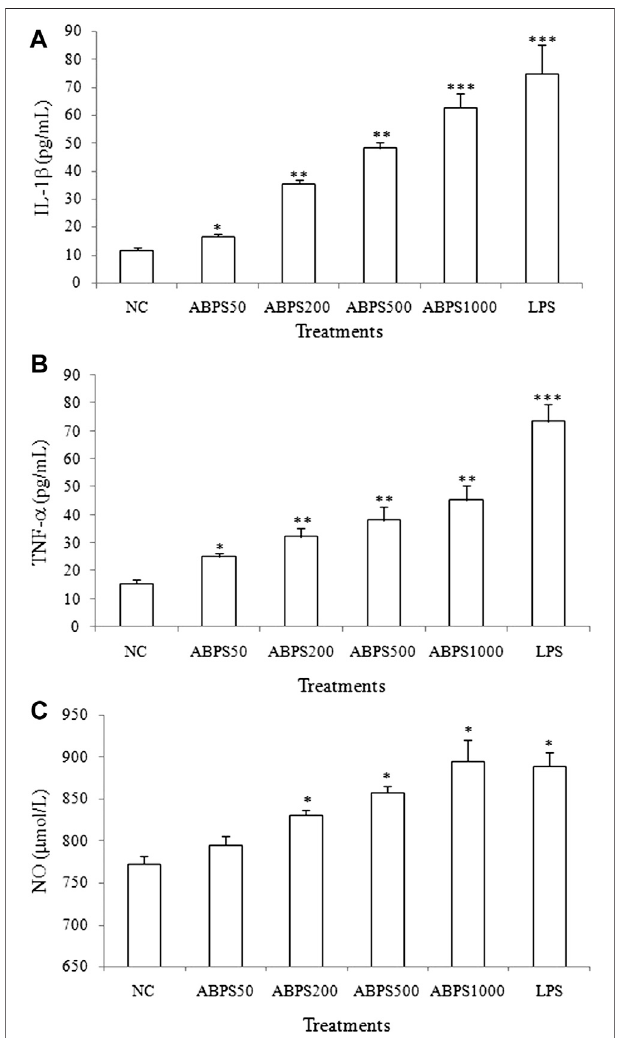
FIGURE 1 | Effects of ABPS on the secretion of cytokines and NO in J774 A.1 cells. The cells were treated with ABPS (0, 50, 200, 500, and 1,000 μ g/ml, respectively) or LPS (5 μ g/ml) for 24 h. Cell culture medium was collected, and the secretion levels of cytokines (A) IL-1 β , (B) TNF- α , and (C) NO were detected. NC: normal control; ABPS50: 50 μ g/ml ABPS treated; ABPS200: 200 μ g/ml ABPS treated; ABPS500: 500 μ g/ml ABPS treated; ABPS1000: 1,000 μ g/ml ABPS treated; and LPS: 5 μ g/ml LPS treated (positive control). * p < 0.05, ** p < 0.01, *** p < 0.001 vs. NC. The values are presented as means ± SD.